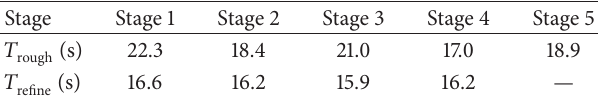
Table 5: Computation time in each stage (Case 1).